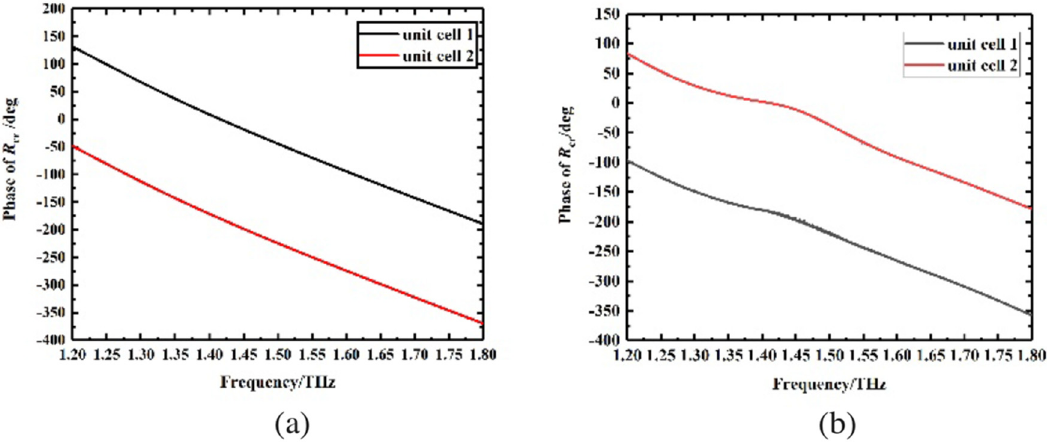
Fig. 4. The phase of R cr when (a) m c =0.85 eV, (b) m c =0 eV.